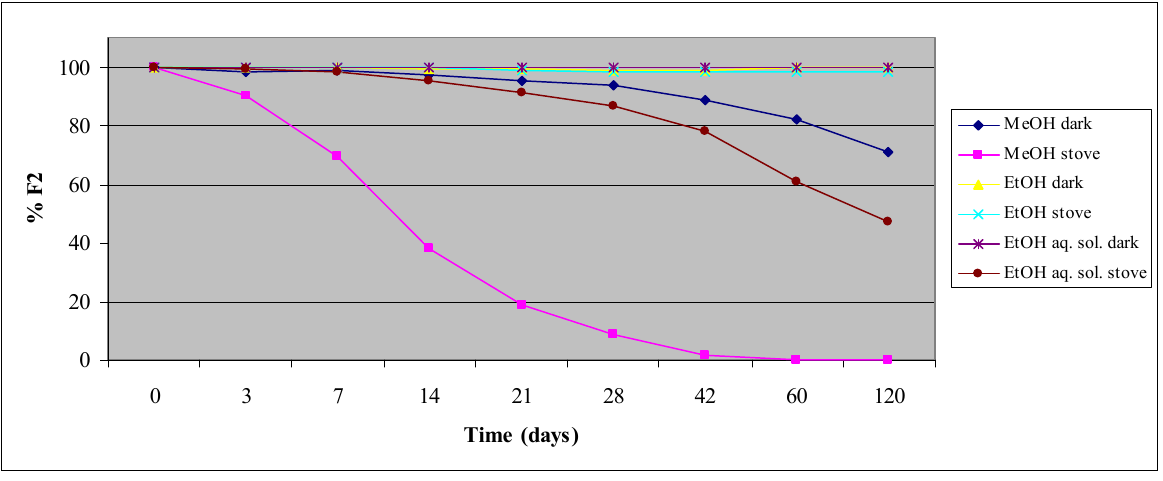
Figure 2. F2 stability in different solutions under different storage conditions.